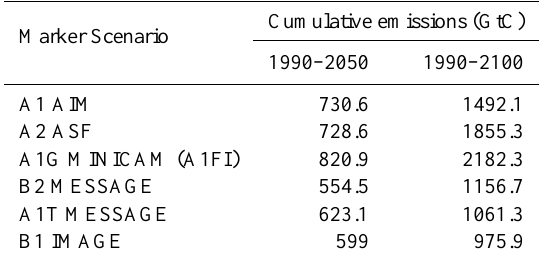
Table 1. Cumulative projected emissions under six SRES marker scenarios (after Nakicenovic and Swart,